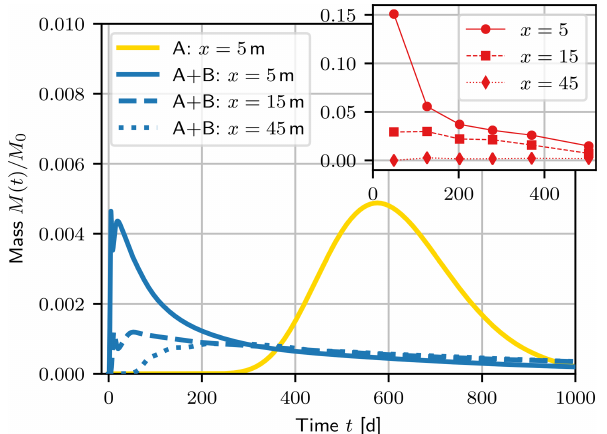
Figure 8. Breakthrough curves: total mass M(t)/M 0 versus time at selected control plane locations for inclusion structure (A+B), (blue) at x = 5m (solid), x = 15m (dashed), and x = 45m (dotted) and for deterministic structure (A) at x = 5m (solid yellow line). Reported mass values for MADE at the three locations (red mark- ers) are given in the subplot. Note the difference in scale due to the spatial averaging of experimental